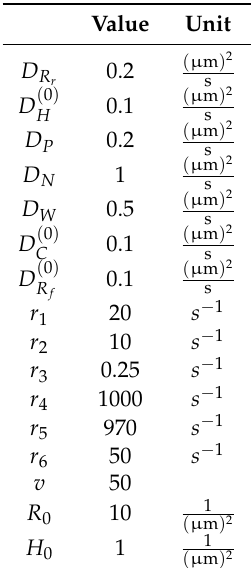
Table 2. Basic parameter set for the sPDE model evaluations, Equations (5a)–(5g), (6a)–(6c) and (7a)–(7c). Parameters determining the basic diffusion–reaction parameters and initial conditions. We emphasize that our code is not restricted to these parameters in any way and the stability does not depend on the use of the parameters reported in this